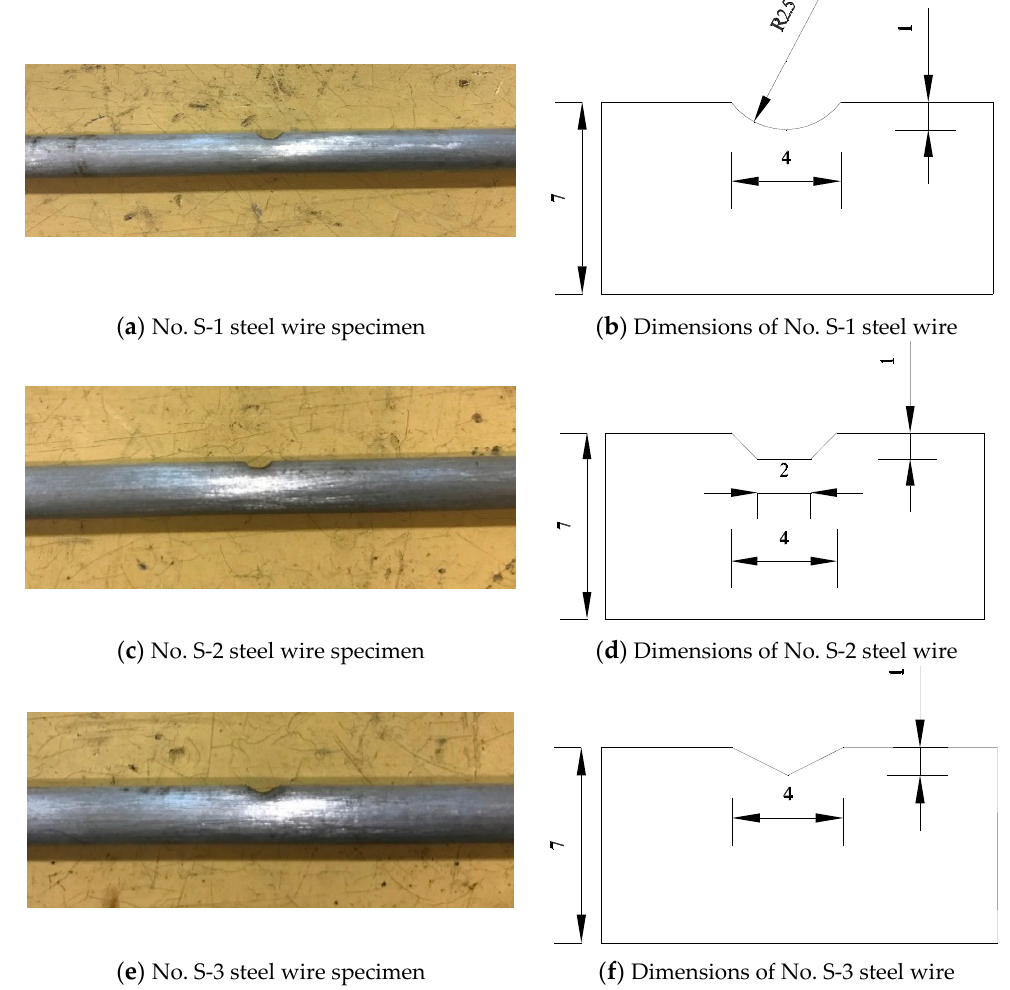
Figure 19. Wire specimens and schematic diagram of steel wire with machine-cut notches of different shapes. Table 7. The life of steel wire with machine-cut notches of different shapes. Stress Rangexiaomei/MPa